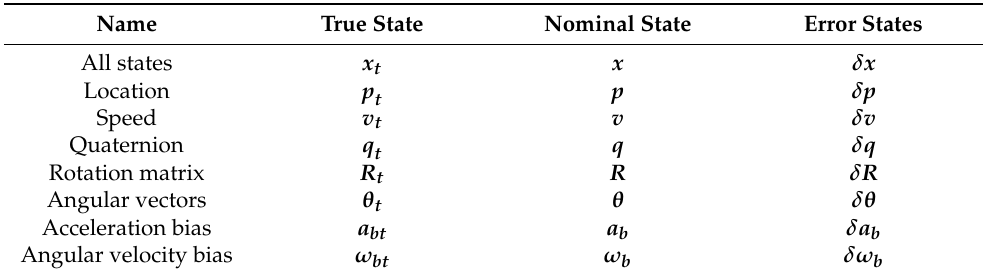
Table 1. The definition of variable